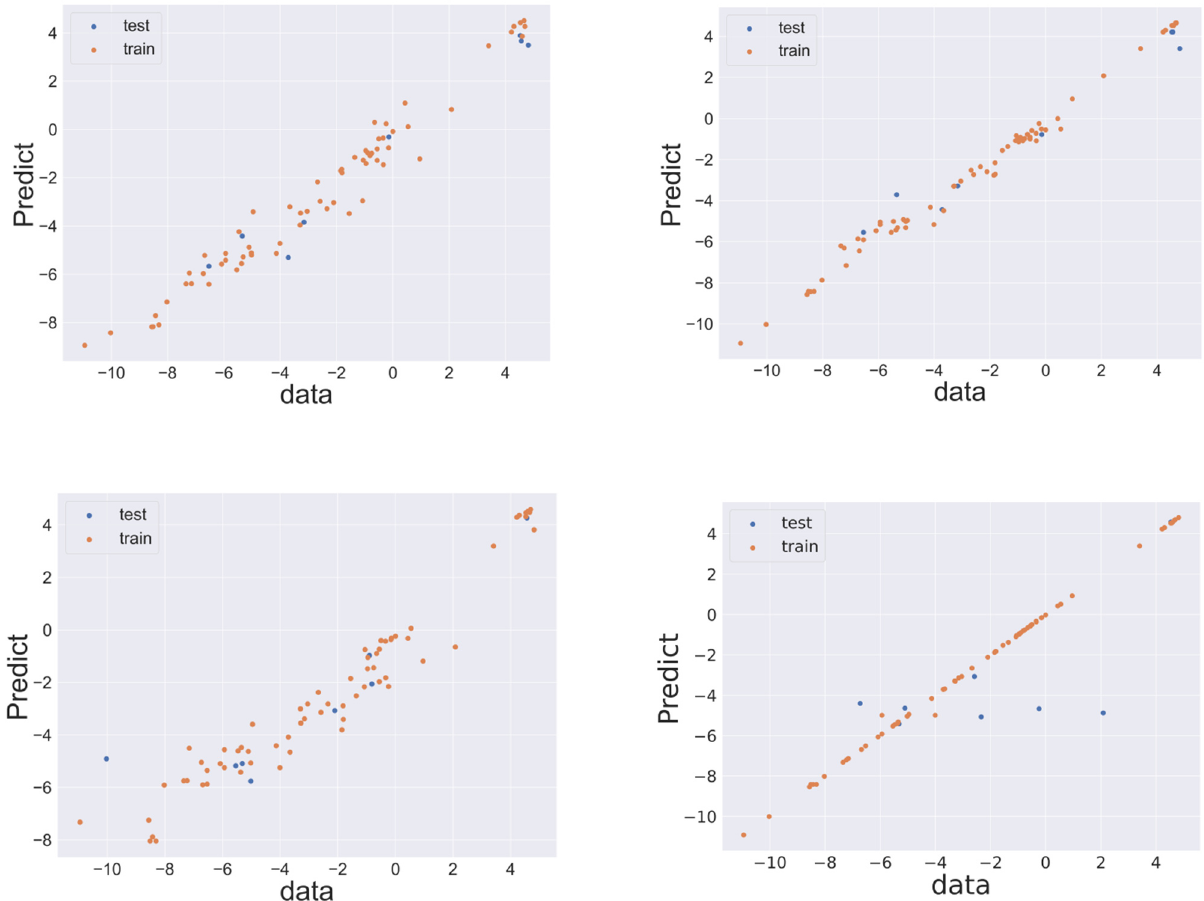
Figure 2. Relationship between objective feature values in the dataset and the predicted values. Top row : descriptors/random forest ( left ), and Morgan fingerprint/AdaBoost ( right ); Bottom row : Morgan fingerprint/random forest ( left ), and Morgan fingerprint/XGBoost ( right ). In all panels, the blue and orange markers indicate test and training data, respectively.